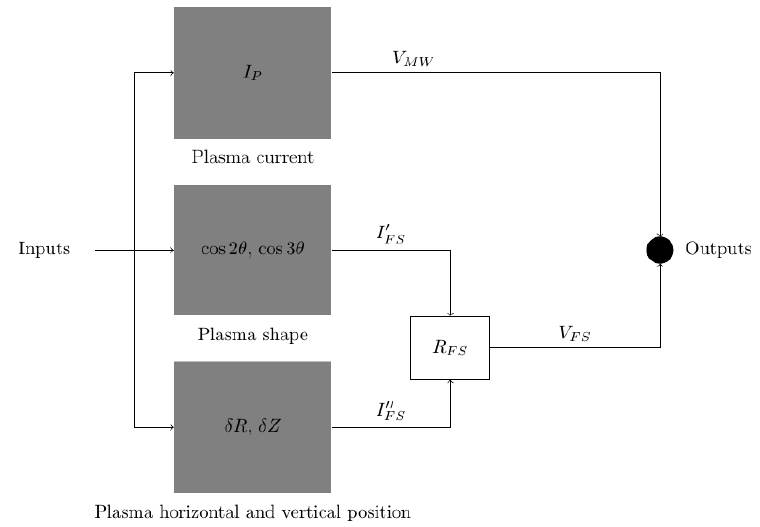
Figure 3. Block scheme of the axisymmetric magnetic control